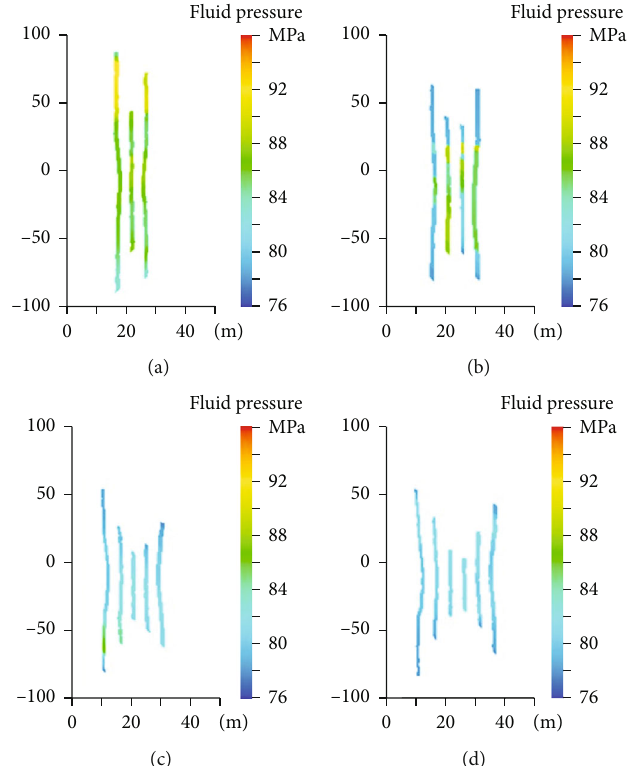
Figure 3: E ff ects of di ff erent numbers of clusters on fracture geometry: (a) 3 clusters, (b) 4 clusters, (c) 5 clusters, and (d) 6 clusters.